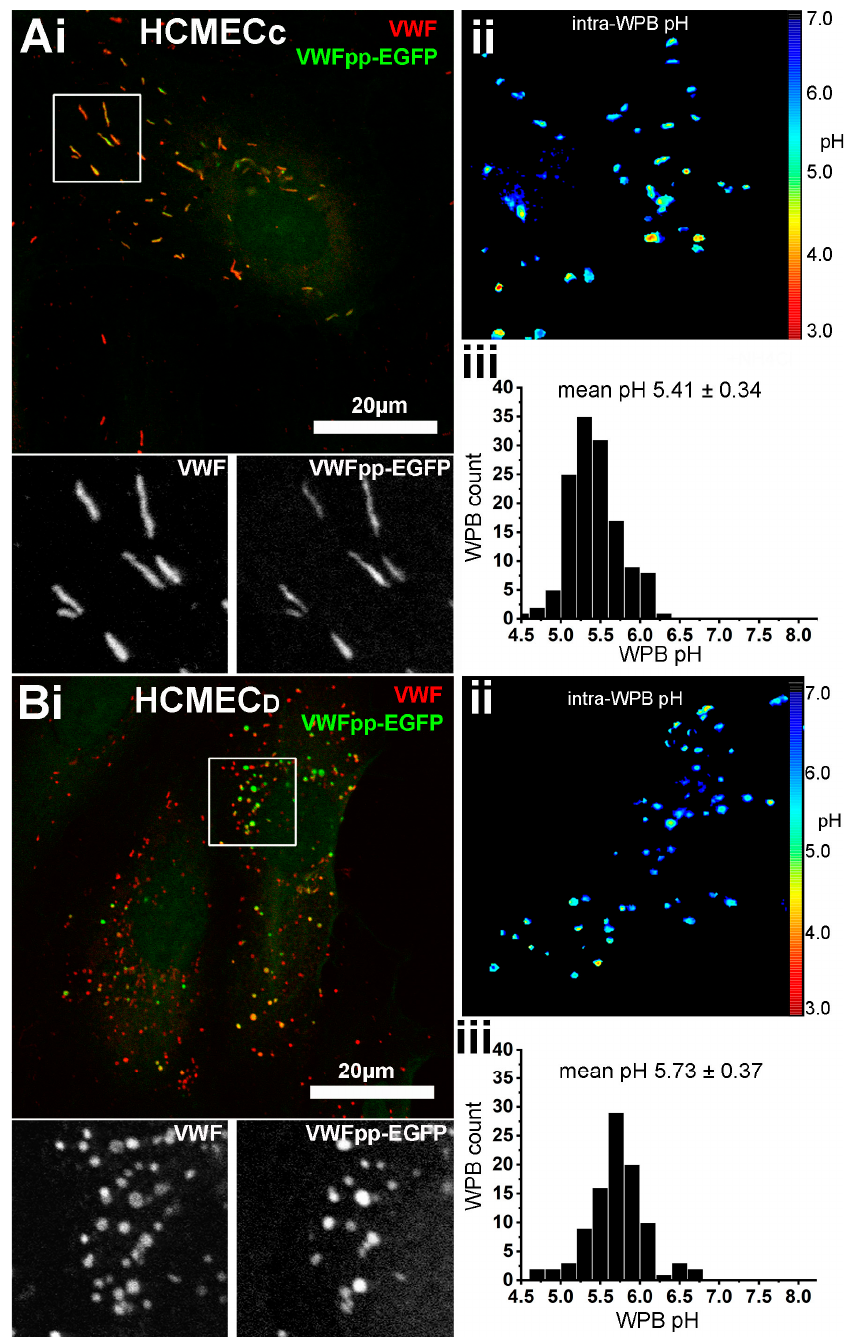
Figure 6. The Intra-luminal pH of WPBs in HCMEC D is marginally less acidic than those of HCMEC C . HCMEC C ( Ai ) and HCMEC D ( Bi ) expressing VWFpp-EGFP to specifically label WPBs. Regions in ( Ai , Bi ) indicated by white boxes are shown in greyscale below the colour images. ( Aii , Bii ) Pseudocolour representations of the calculated intra-WPB pH in single cells and ( Aiii – Biii ) the distributions of intra-organelle pH for individual WPBs in HCMEC C (n = 135 WPBs, 7 cells, mean pH 5.41 ± 0.02, s.e.m.) and HCMEC D (n = 92 WPBs, 8 cells, mean pH 5.73 ± 0.03, s.e.m.), respectively. WPB pH in HCMEC C versus HCMEC D , p < 0.0001, unpaired t-test, GraphPad Prism. HCMEC; human cardiac microvascular endothelial cells ( C ; control, D ; dilated cardiomyopathy). VWFpp-eGFP; von Willebrand factor propeptide-eGFP. WPBs; Weibel–Palade bodies.